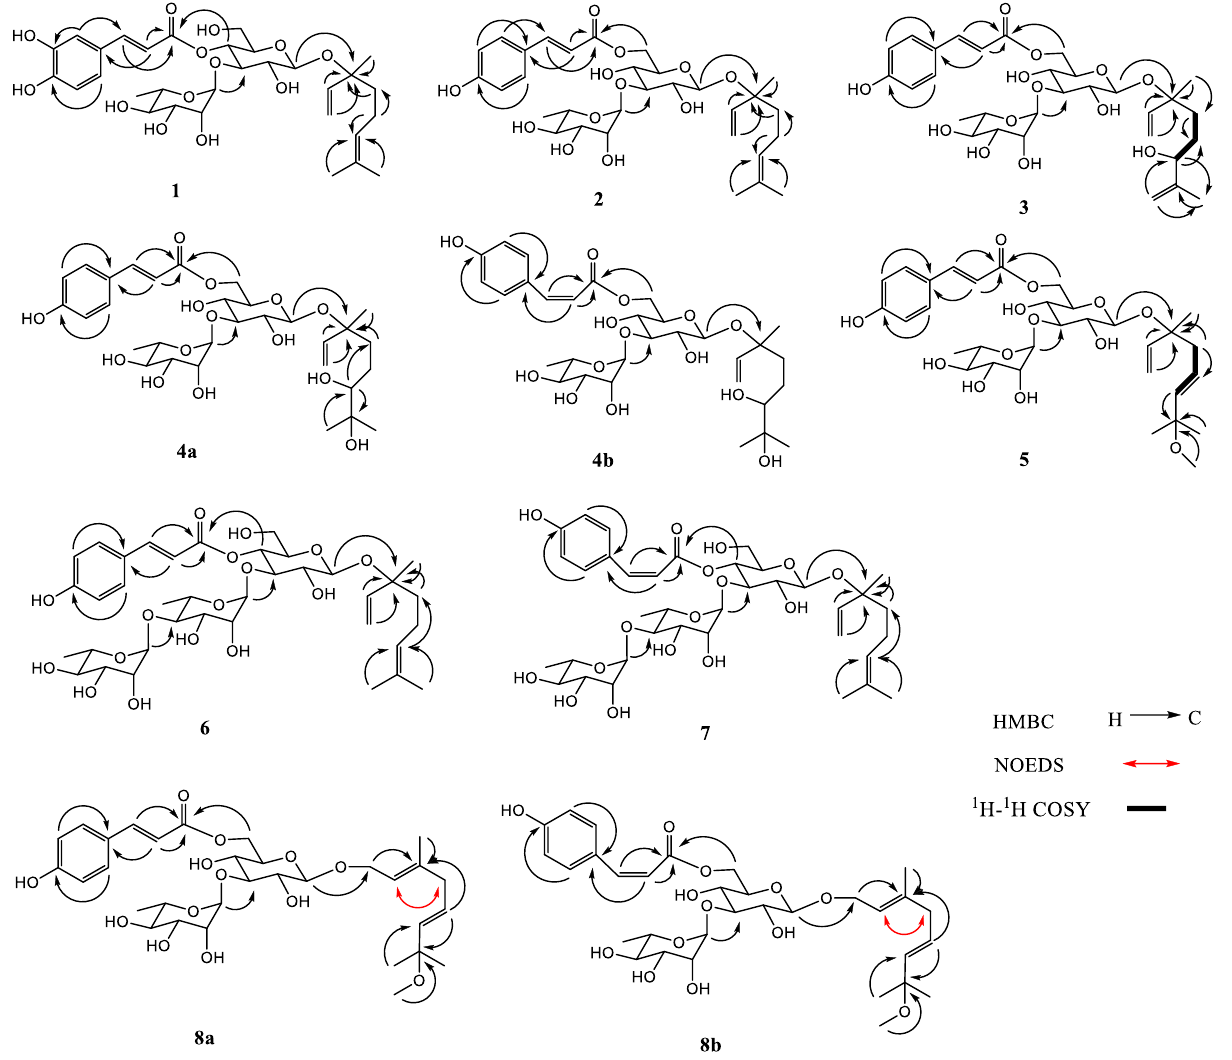
Figure 2. Key HMBC, 1 H- 1 H COSY and NOEDS correlations of compounds 1 – 8 . Compound 2 was determined as C 31 H 44 O 12 by HRESIMS ( m / z 631.2728 [M + Na] + , calculated 631.2730 for C 31 H 44 NaO 12 ). The 1 H and 13 C NMR data of 2 (Tables 1 and 2) were similar to those of 1 , except the 4- O - trans -caffeoyl in 1 was replaced by a trans - p -coumaroyl [ δ H 6.81, 7.45 (2H each, d, J = 8.8 Hz)] at a different position in 2 .